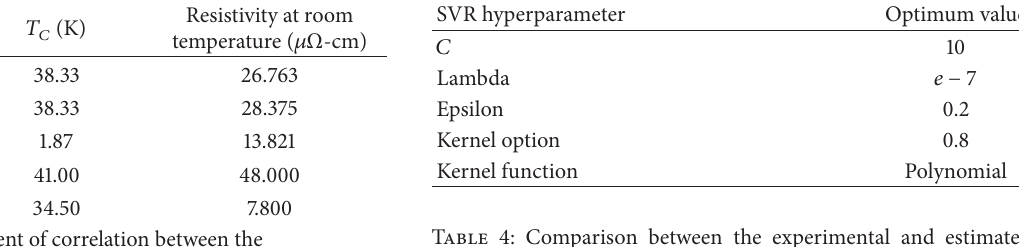
Table 4: Comparison between the experimental and estimated value of 𝑇 𝐶 during the course of developing